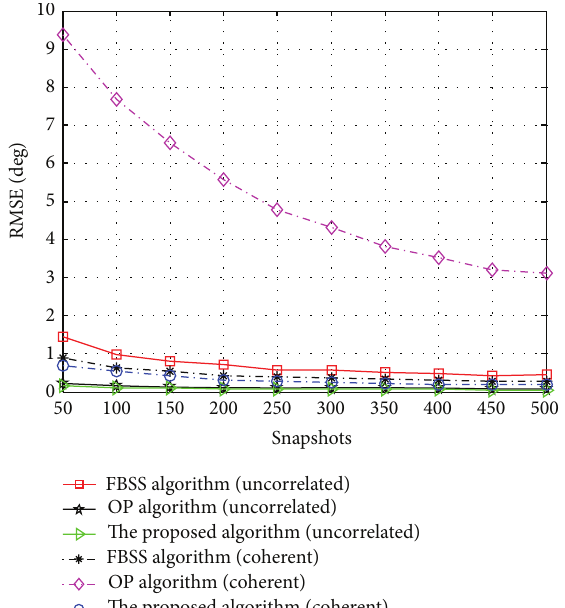
Figure 5: NPS of the DOA estimates versus input snapshots for the uncorrelated and coherent